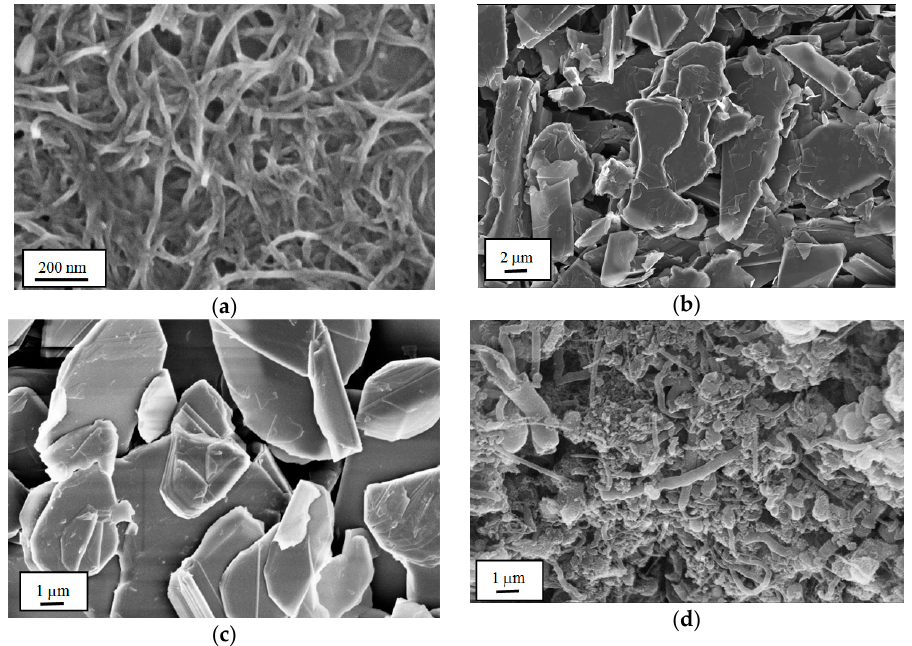
Figure 10. SEM images of nanofillers used in hybrid nanocomposites: ( a ) MWCNT; ( b ) f-GNP; ( c ) BNNS; ( d ) BNNTs. ( c ) BNNS; ( d )